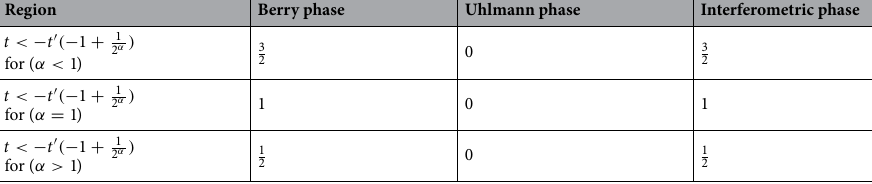
Region Berry phase Uhlmann phase Interferometric